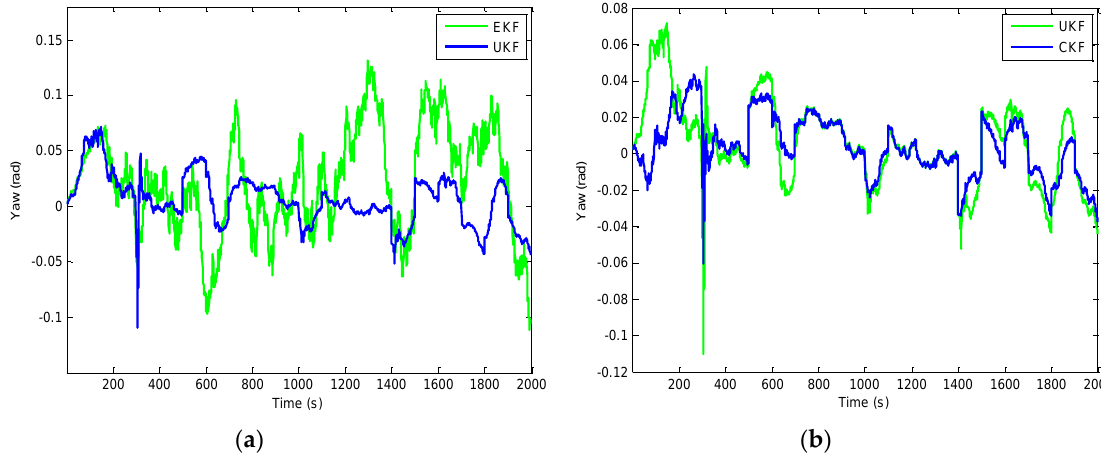
Figure 7. Comparison of position errors based on the UKF, CKF, and FACKF — Scenario 1. ( a ) East position error; ( b ) North position error. Sensors 2016 , 16 , 1167